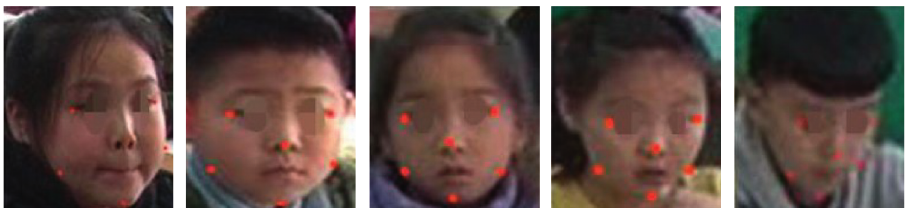
Figure 9: Result of key point filter.